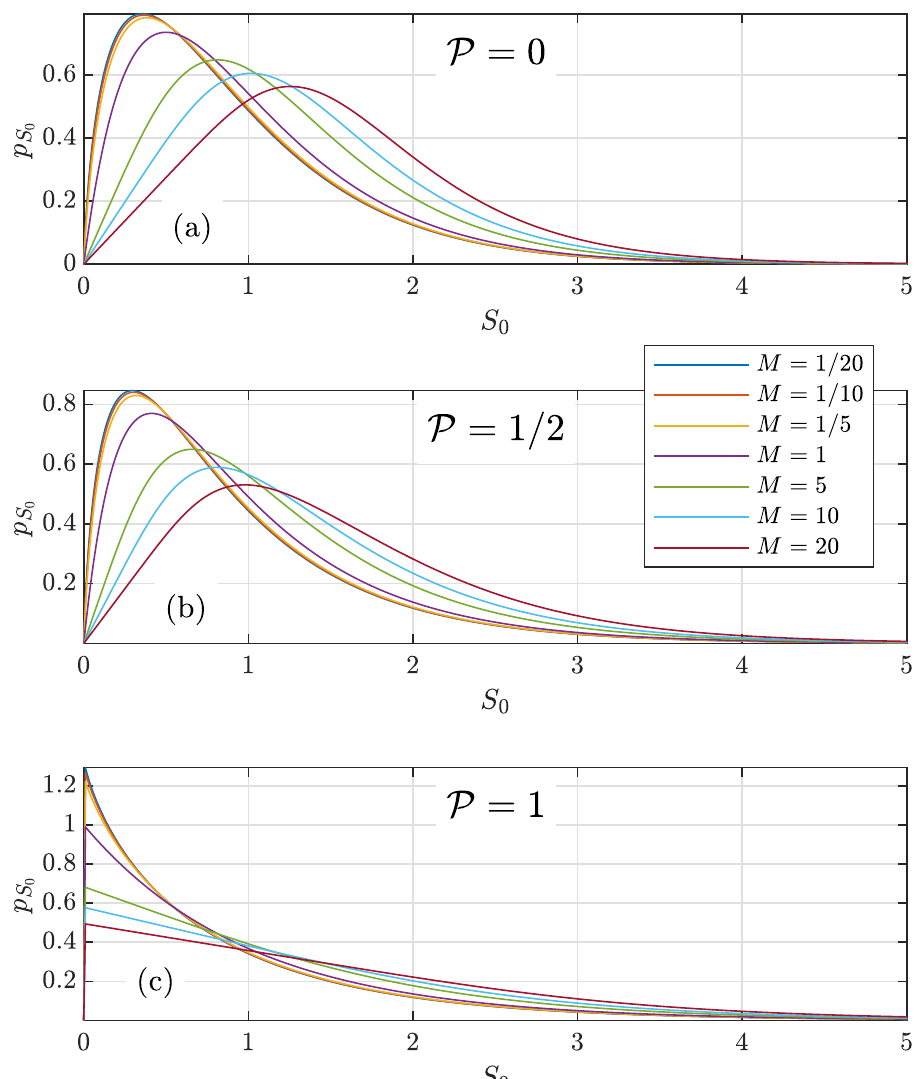
Figure 2. PDF of S 0 p S [Equation (33)] for various values of M : ( a ) P = 0, ( b ) P = 1/2, and 0 ( c ) P =